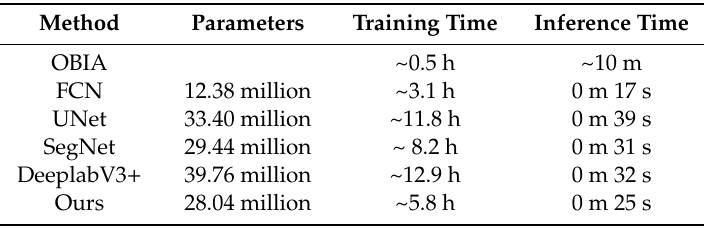
Table 6. The e ffi ciency of di ff erent